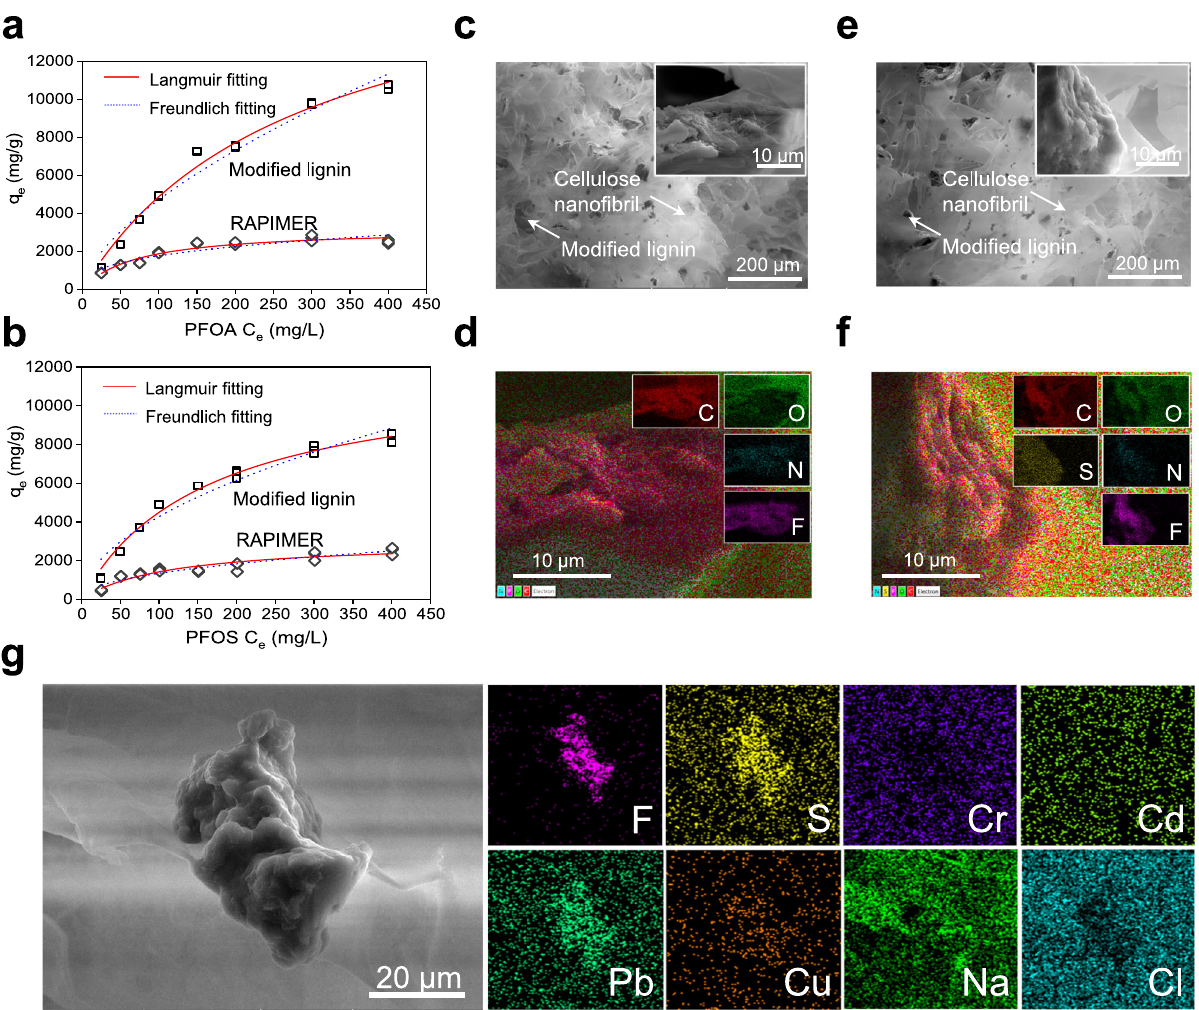
Fig. 4 The isothermal models and absorption mechanism. a The adsorption isotherms of the modi fi ed lignin and RAPIMER composite binding with PFOA. b The adsorption isotherms of the modi fi ed lignin and RAPIMER composite binding with PFOS. The solid red line: Langmuir fi tting model. The dotted blue line: Freundlich fi tting model. Top fi tting: modi fi ed lignin. Bottom fi tting: RAPIMER. Each concentration had triplicate measurements and all overlapped points were shown in the fi gures (the invisible standard derivations are not applied in the fi gure due to the small variations). The experiment was reproduced n = 3 times. c The SEM image of PFOA adsorbed RAPIMER composite. d The EDX image of PFOA adsorbed RAPIMER composite with color coding for different elements. Red: carbon, green: oxygen (28.0 wt%), blue: nitrogen (1.4 wt%), purple: fl uorine (21.4wt%). e The SEM image of PFOS adsorbed RAPIMER composite. f The EDX image of PFOS adsorbed RAPIMER composite with color coding for different elements. Red: carbon (51.0 wt%), green: oxygen (27.2 wt%), blue: nitrogen(1.1 wt%), purple: fl uorine(19.0 wt%), yellow: sulfur (1.7 wt%). g The SEM and EDX images of PFAS/dye/metals contaminants as-adsorbed RAPIMER composite with color coding for different elements. purple: fl uorine, yellow: sulfur, blue violet: chromium, light green: cadmium, emerald green: lead, orange: copper, green: sodium, and blue green: chlorine. The results were based on three repeated measurements and all replicates are shown in the fi gures. The experiment was reproduced n = 3